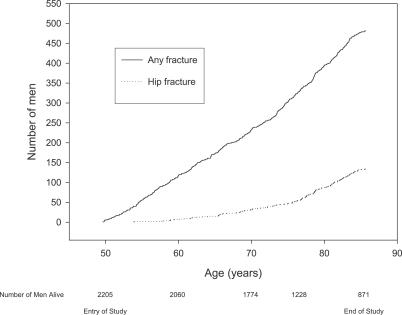
Cumulative Number of Hip Fractures and Fractures of any Type after Study Entry at Age 50 y and during Follow-up